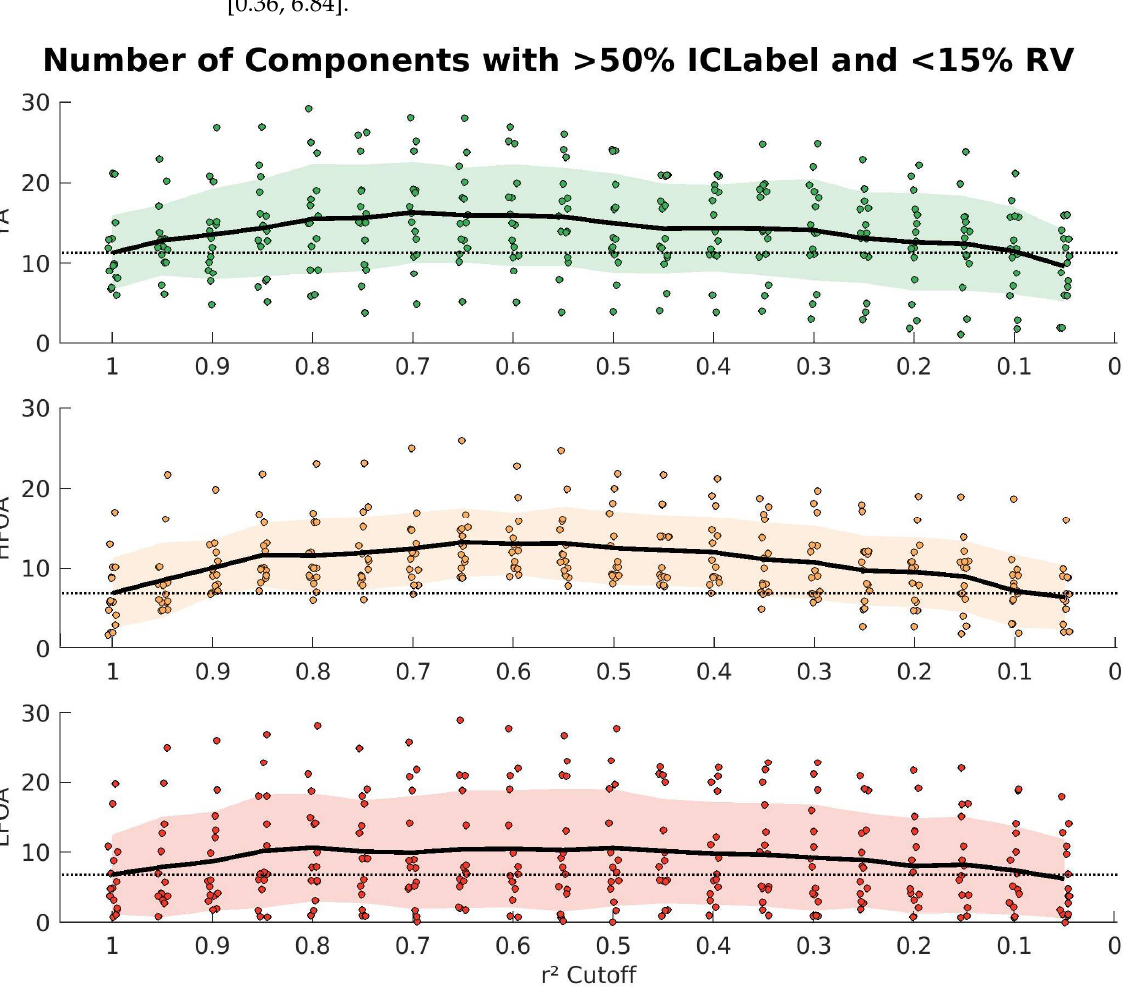
Figure 4. Results of the parameter sweep with separated subject groups for the 4 s window. Each plot shows a different group: young adults (green), high functioning older adults (yellow), and lower functioning older adults (red). The average from no cleaning is again shown as a dashed black line. The mean is a black line across the plot and the standard deviation is the shaded